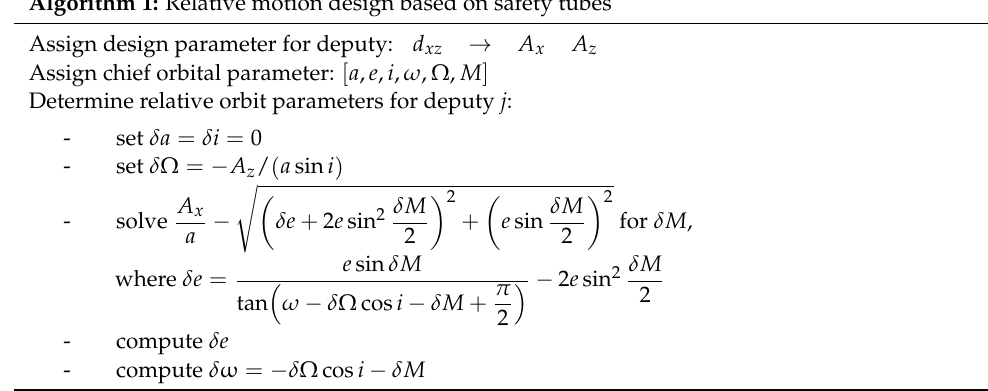
Algorithm 1: Relative motion design based on safety